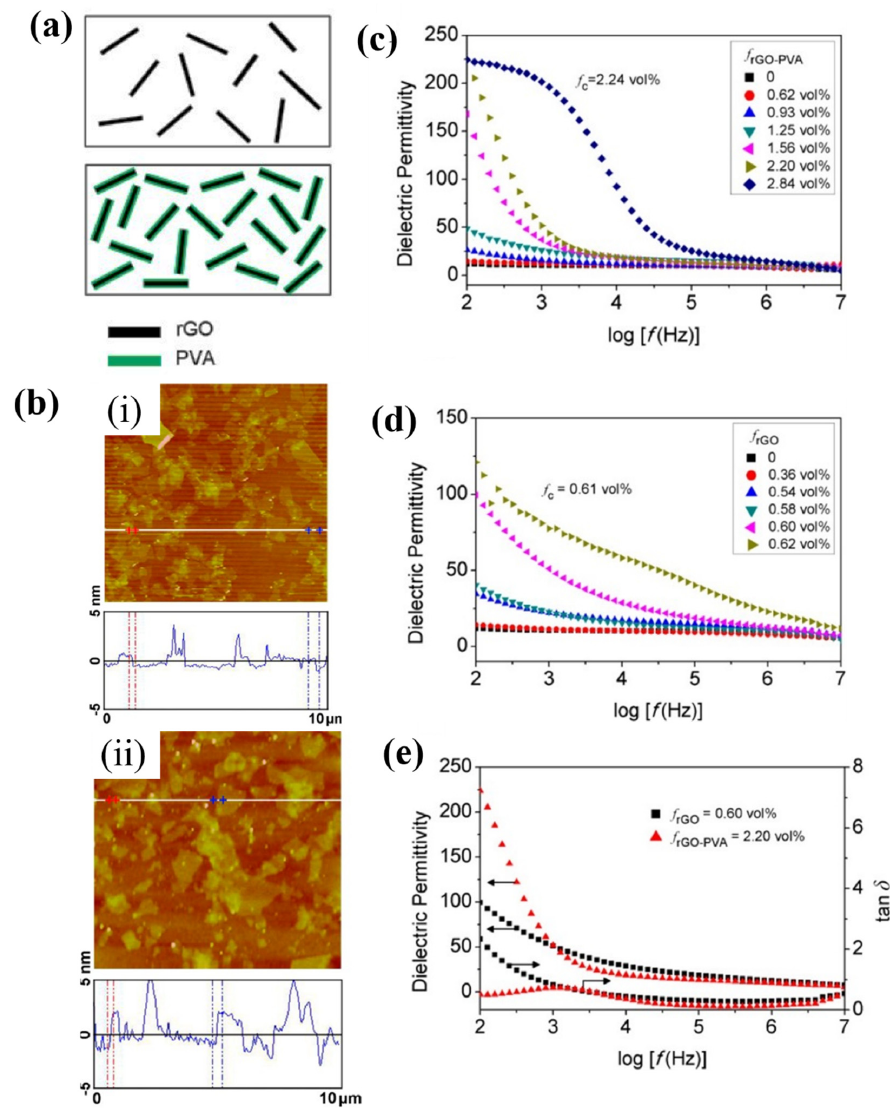
Figure 12. ( a ) Sketches of rGO and rGO-PVA. ( b ) AFM images of ( i ) rGO and ( ii ) rGO-PVA. Dielectric permittivity of ( c ) rGO-PVA/PVDF films and ( d ) rGO/PVDF films. ( e ) Dielectric properties of nanocomposites. Adapted with permission [107]. Copyright 2012, American Chemical Society.